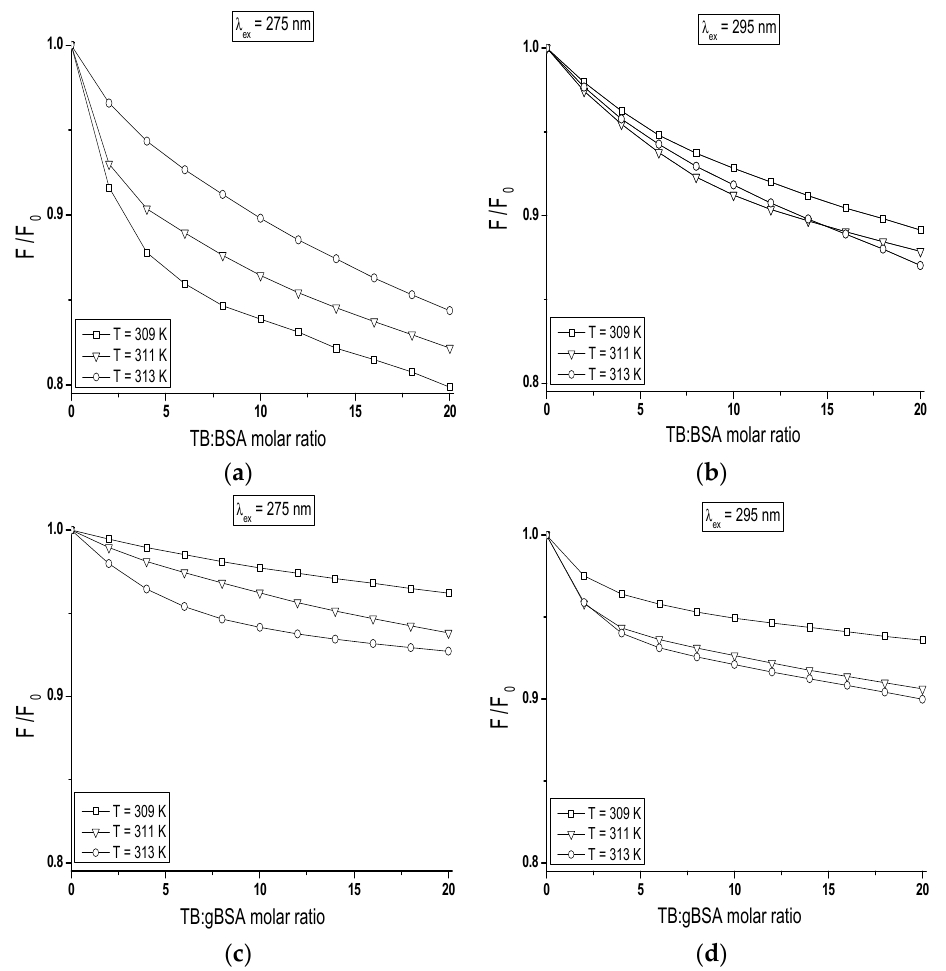
Figure 8. Comparison of the quenching curves of: ( a , b ) BSA; and ( c , d ) gBSA, in the presence of TB at temperature in the range between 309 K and 313 K; ( a , c ) λ ex = 275 nm; and ( b , d ) λ ex = 295 nm. The error bars are smaller than the symbols.